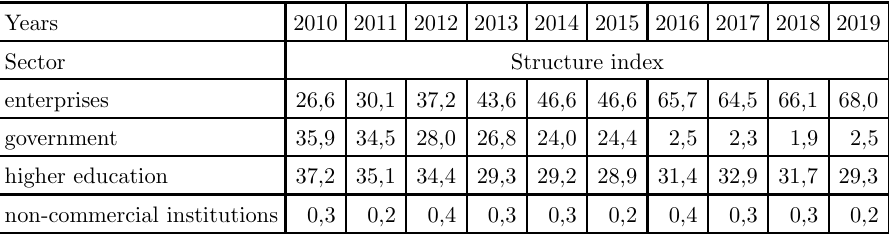
Structure of internal R&D expenditures by executive